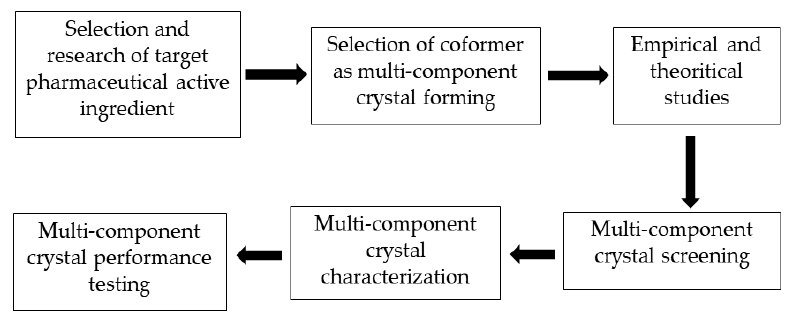
Figure 7. Stages of a multicomponent crystal development strategy.